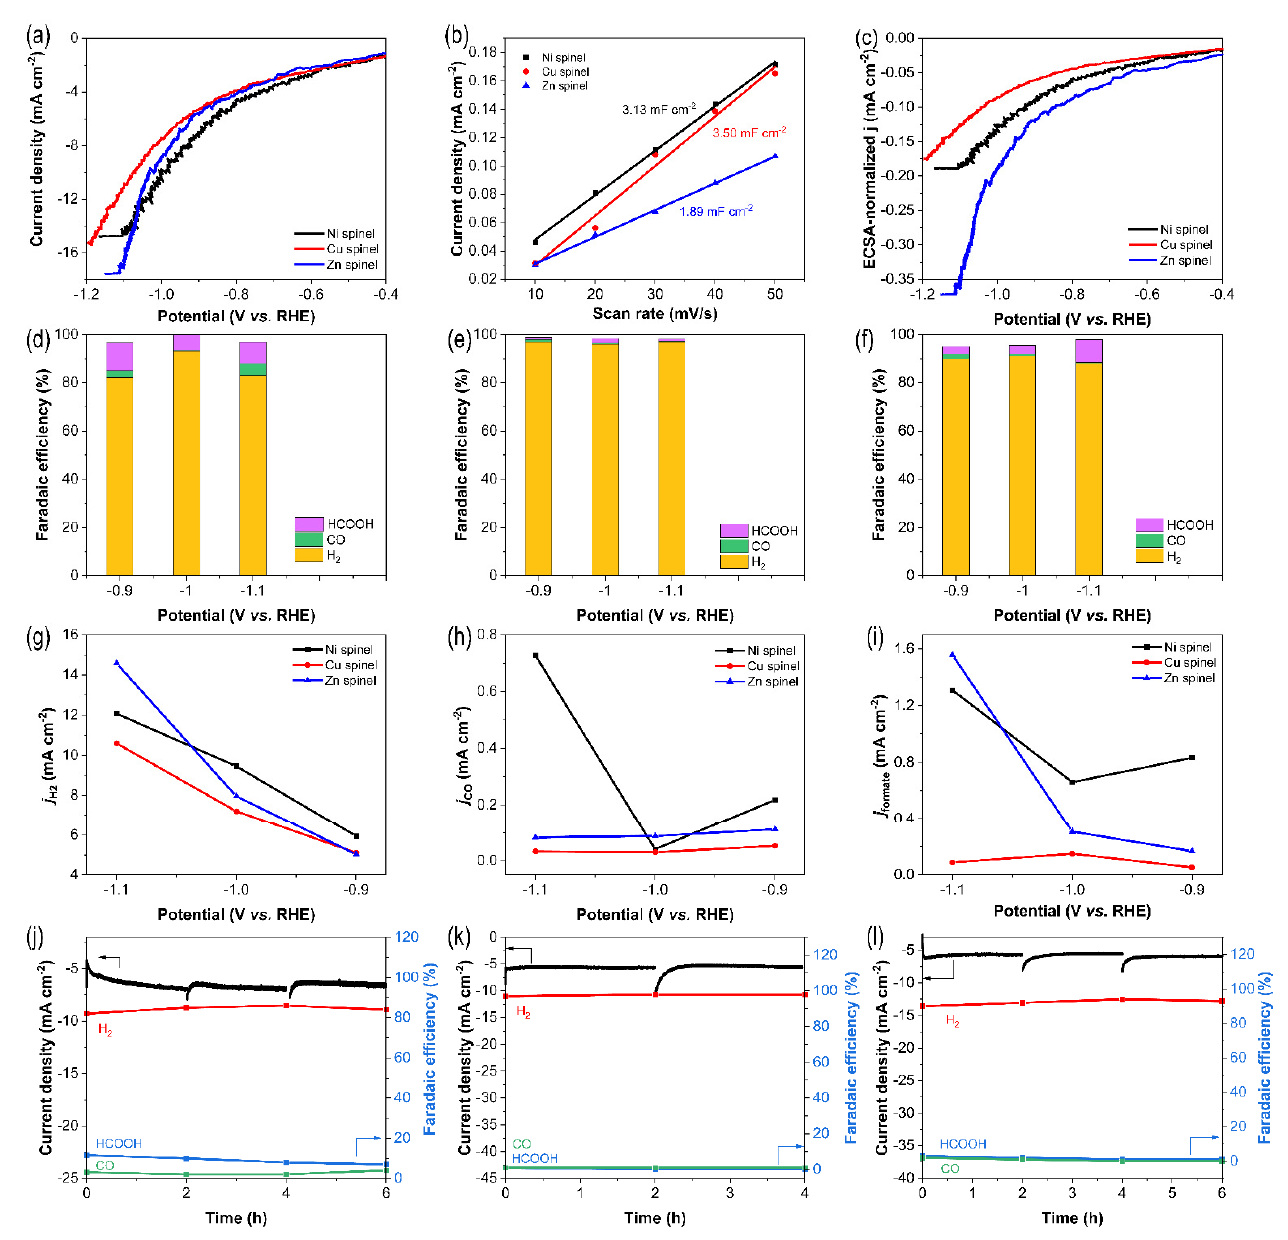
Figure 5. CO 2 RR performance of Ni, Cu, and Zn spinel: ( a ) LSV curves, ( b ) plots showing the extraction of the C dl for the estimation of the ECSA, ( c ) ECSA-normalized LSV curves, ( d – f ) FE of major products vs. potential for the Ni, Cu, and Zn spinel catalyst at a potential range of − 0.9 V to − 1.1 V in 0.1 M KHCO 3 , ( g ) H 2 , ( h ) CO, and ( i ) formate current density plots as a function of potential (vs. RHE) during CO 2 flow rate of 20 sccm, ( j – l ) stability test of Ni, Cu, and Zn spinel, Left y -axis: the current density ( j ) of Ni, Cu, and Zn spinel at − 0.9 V vs. RHE. Right y -axis: the faradaic efficiency of H 2 , HCOOH, and